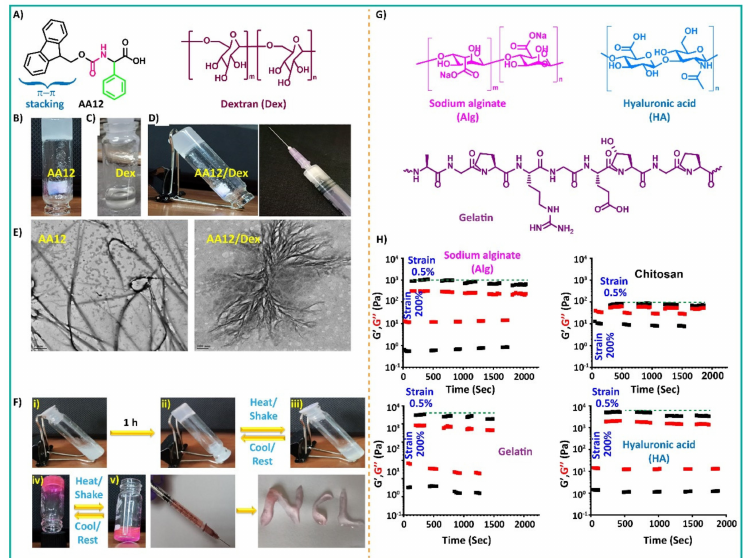
Figure 20. ( A ) Chemical structure of the Fmoc-capped amino acid (AA12) and dextran. ( B ) Pho- tographs of inverted vial of AA12 hydrogel. ( C ) Detran solution and ( D ) AA12/dextran hydrogel in an inverted vial and syringe. ( E ) TEM images of AA12 and AA12/dextran hydrogel. ( F ) Stimuli- responsiveness and injectability nature of AA12/dextran hydrogel; reproduced with permission from Ref. [179]. Copyright (2021) John Wiley and Sons. ( G ) Molecular structure of the biopolymers. ( H ) Rheological step-strain measurement showing thixotropicity in the composite gels; reproduced with permission from Ref. [167]. Copyright (2021) MDPI AG;